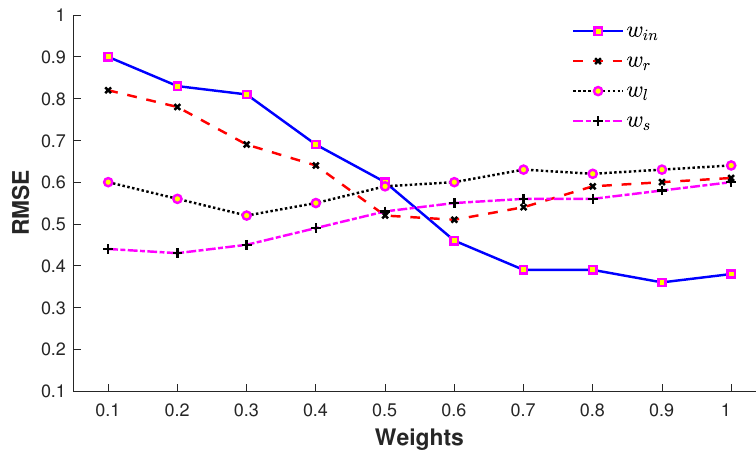
Figure 11. Impact of weights w r , w in , w l , and w s used in